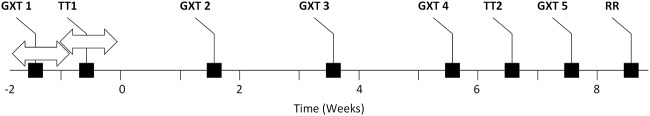
Study design.Study design showing timing of different tests. Time point 0 weeks indicates start of treatment (rHuEPO or placebo) for all participants. GXT, graded exercise test; TT, time trial test; RR, road race.